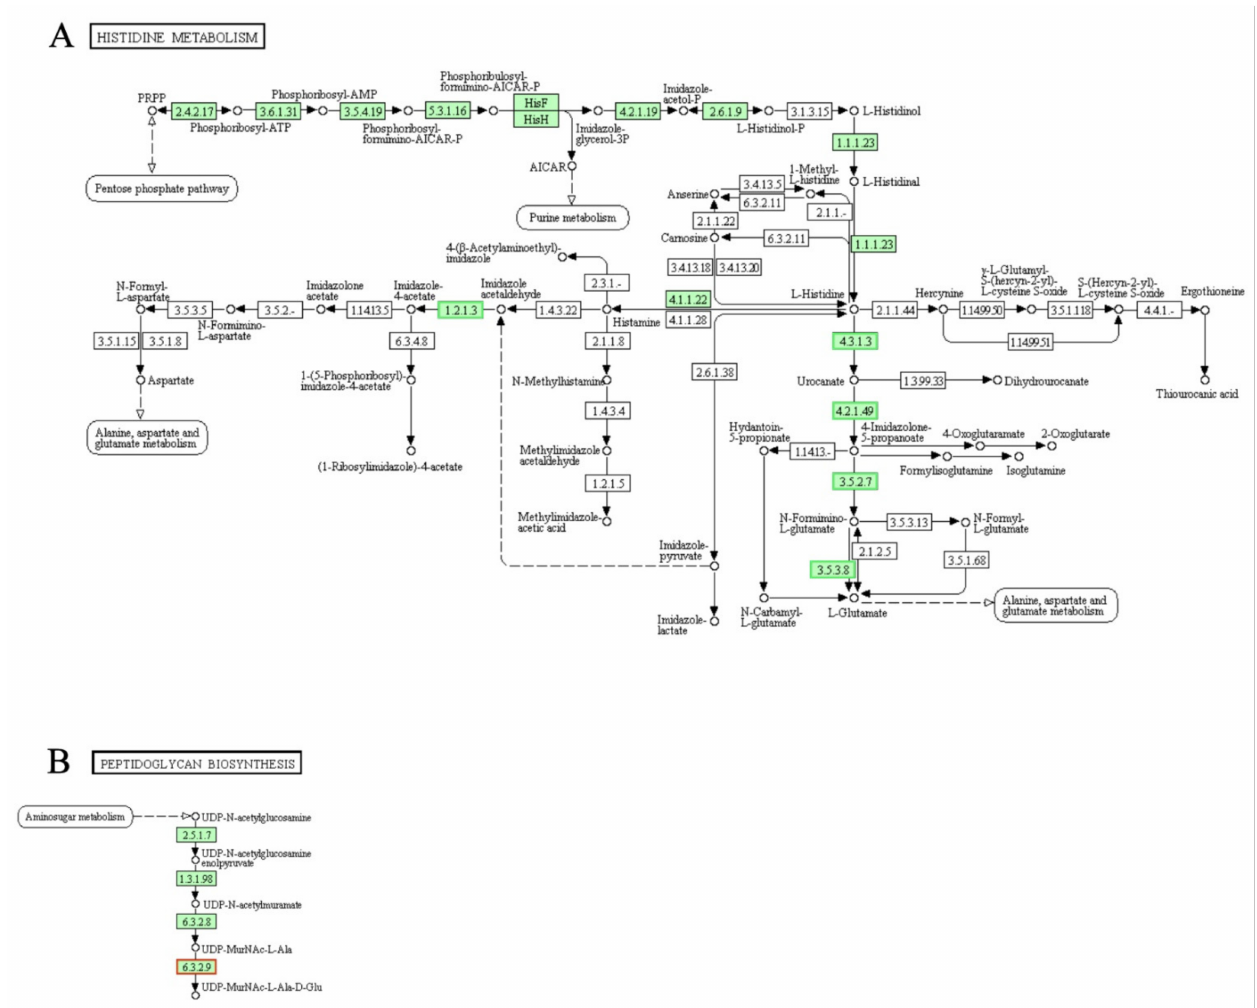
Figure 11. Significantly enriched KEGG pathway “Histidine metabolism” ( A ) and “Peptidoglycan biosynthesis” ( B ); (from KEGG database, green rectangles represent proved Organism-specific gene product and green frames represent down- regulation and red frames represent up-regulation, yellow frames represent both down and